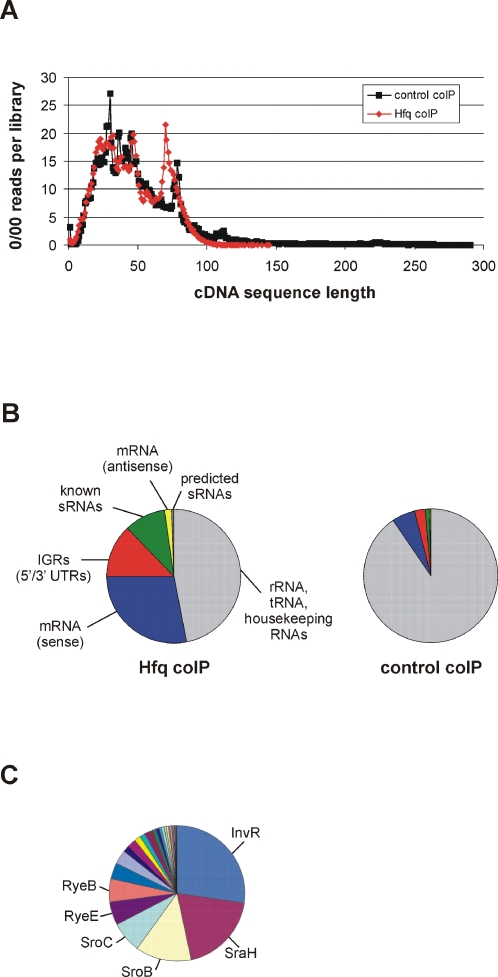
Statistical analysis of the cDNA sequencing results of Hfq-associated RNA.(A) The pyrosequencing results were analyzed by plotting the number of cDNA reads over the read length in bp. The length distribution of all resulting sequences is shown. (B) Pie diagram showing the relative proportions of the different RNA species contained in all sequences that mapped to the Salmonella genome. The rRNA, tRNA and housekeeping RNAs are shown in grey. Left panel: Hfq coIP, right panel: control coIP. (C) Pie diagram showing the relative proportions of all Hfq-associated sequences that unequivocally mapped to known sRNA sequences. The names of the six most frequently recovered sRNAs are given.